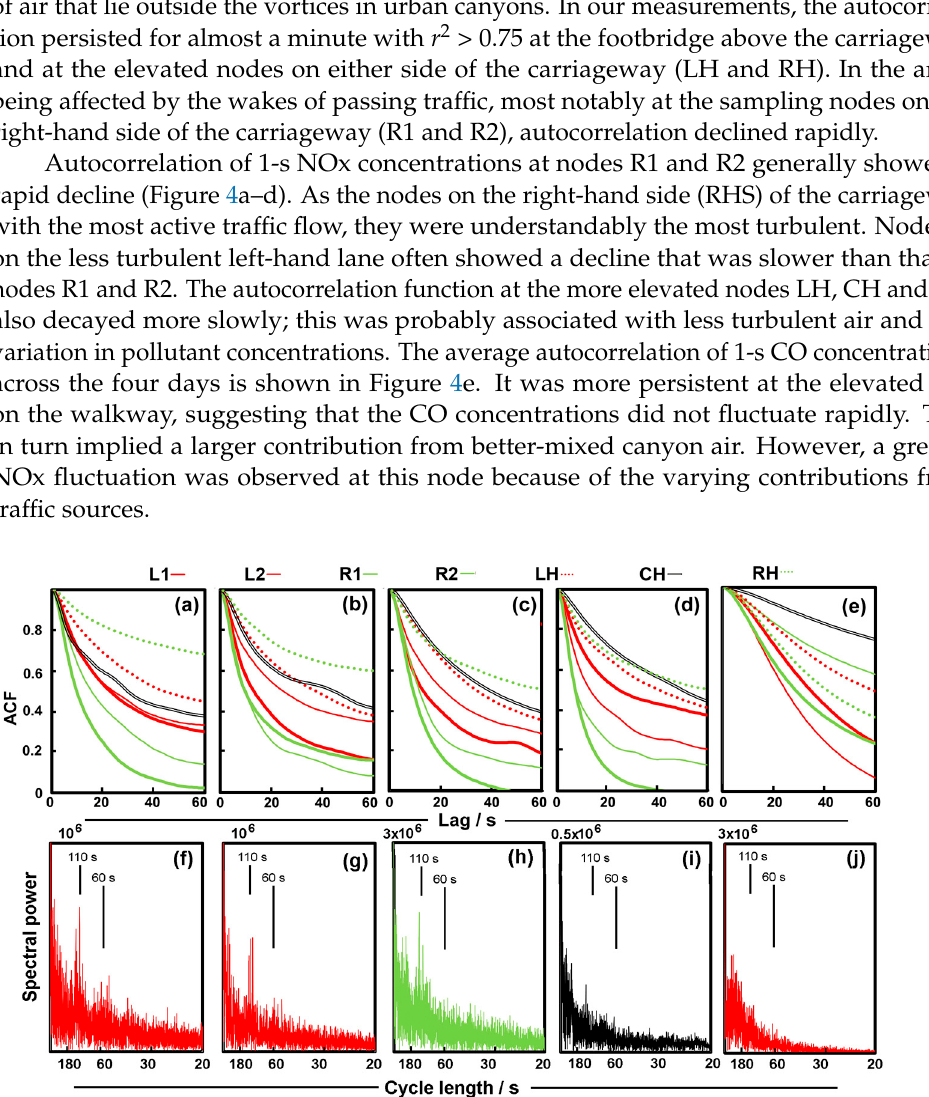
Figure 5. ( a ) The cross-correlation function (CCF) of 1-s NOx concentrations from the other six nodes with R1 on 12–28 and ( b ) CO. ( c ) The lag of each node for both NOx and CO with node R1 determined for the four days. Figure 6. ( a ) The 1-min NOx concentrations when the 1-min average wind speed was <1.0 or ≥ 1.0 m s − 1 in the 4-day cam- paign. Note: The hatched shading is for winds <1.0 m s − 1 . ( b ) The average concentration of CO when 1-min average wind speed was <1.0 or ≥ 1.0 m − 1 in the 4-day campaign.